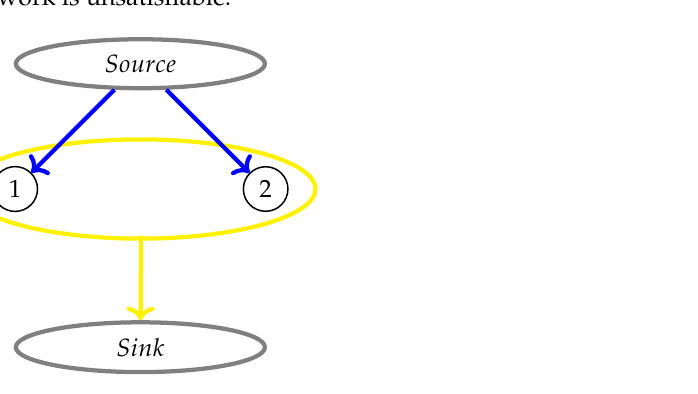
Figure 2. The resolvable network of the pigeon hole problem with 2 pigeons and 1